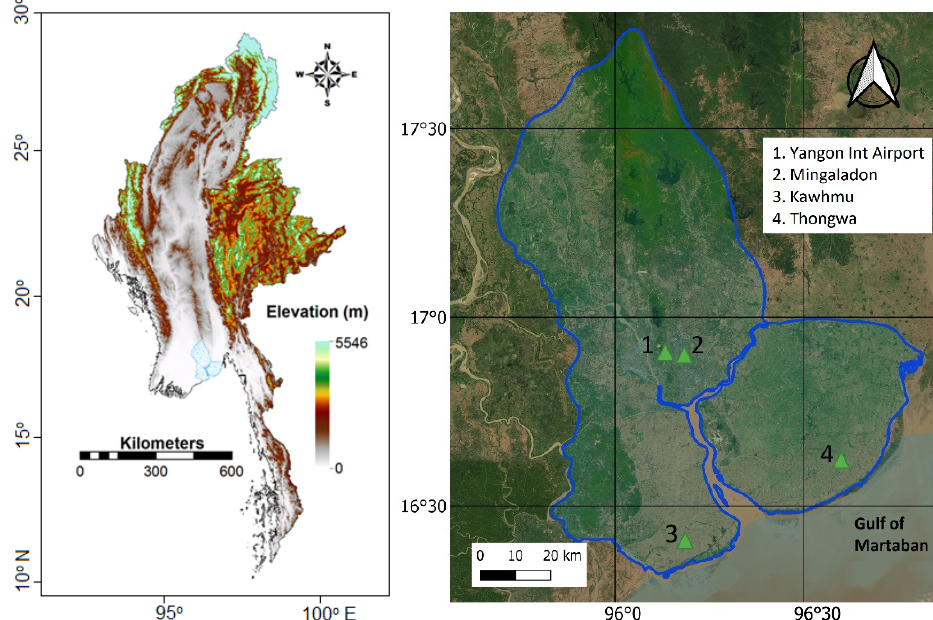
Figure 1. Location of Yangon in the map of Myanmar. The locations for rainfall intensity–duration– frequency curve generation are also shown on the map of Yangon.